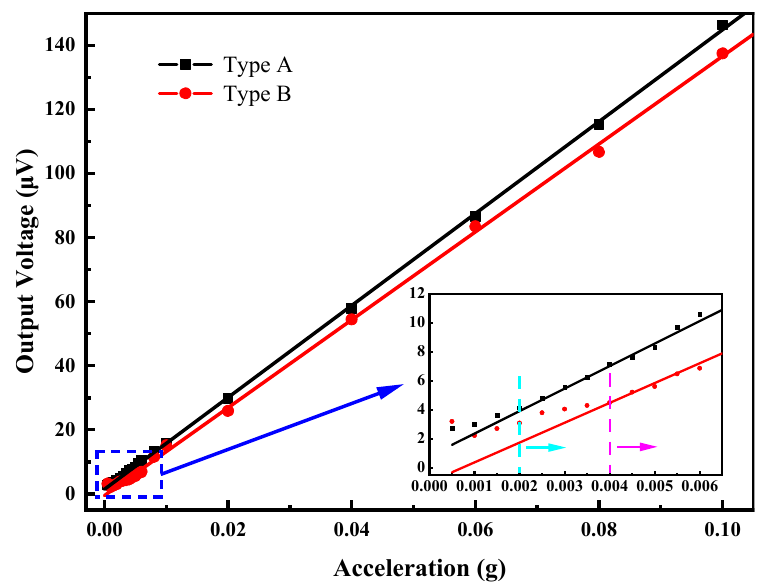
Figure 10. Minimum detectable signal (MDS) of Type A and Type B piezoelectric MEMS accelerometers at 400 Hz.